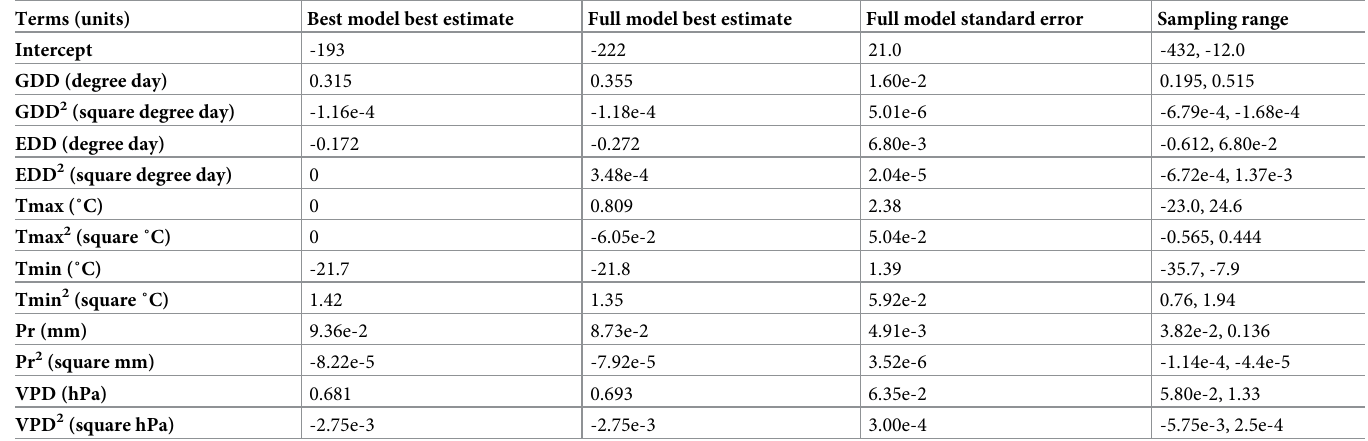
Table 1. List of model estimates and parameter sampling